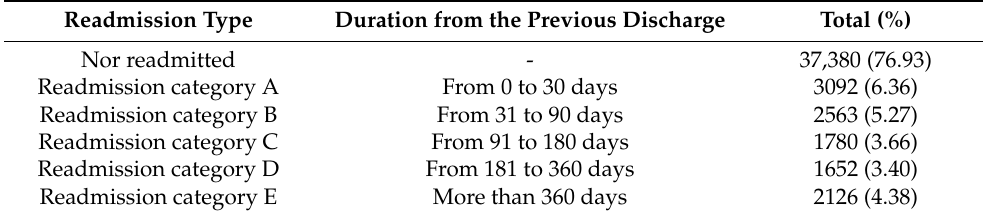
Table 1. Readmission type based on length of readmission.